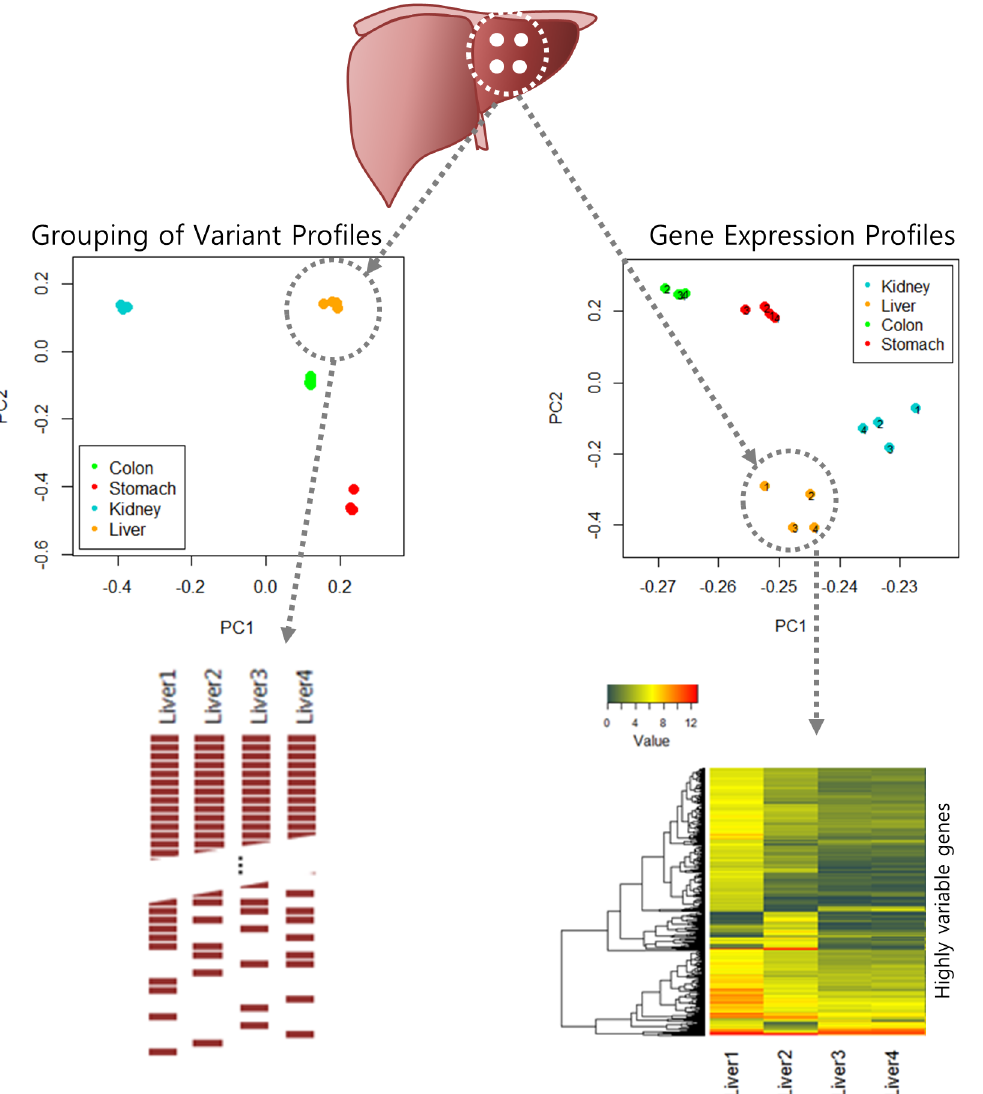
Fig 1. Schematic overview of the comparison of mutation and expression patterns from multiregion sequencing of whole-exome and whole- transcriptome. Regional samples of each cancer were closely grouped over 2-D space based on principal component analysis (PCA). The differences in genomic variants and in gene expression between sequencing are